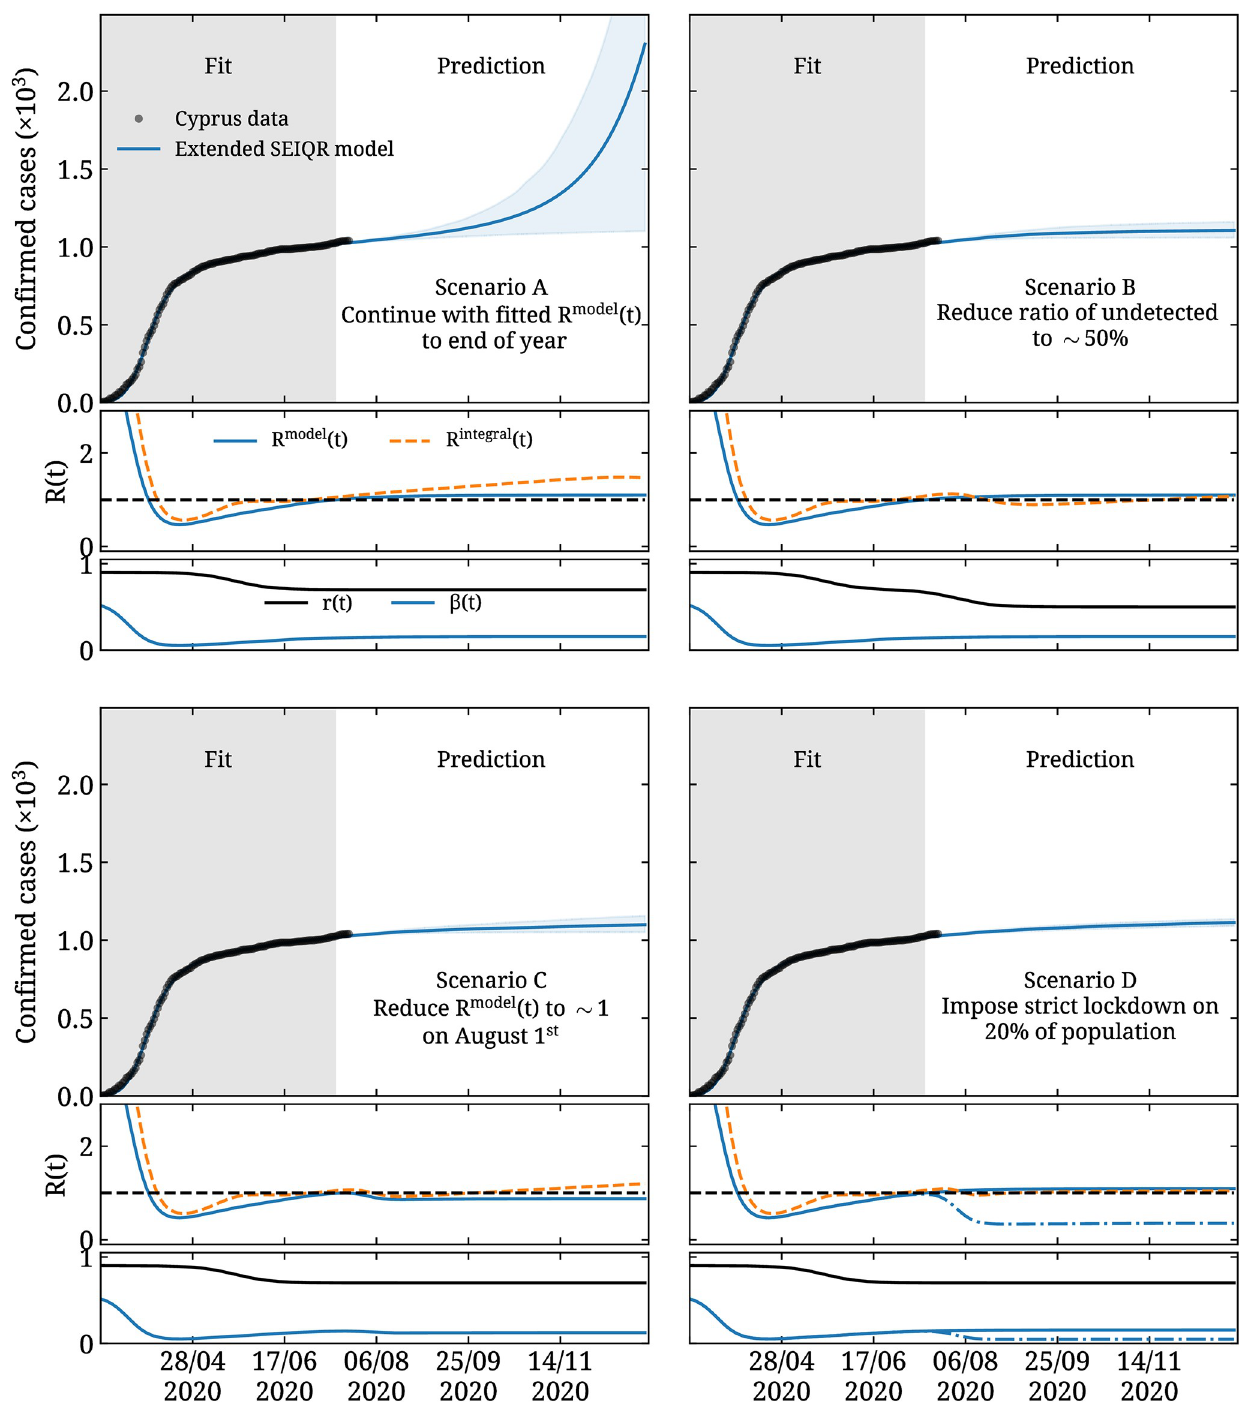
Fig 6. Forecasting using the SEIQR model. Predicting the evolution of COVID-19 for scenarios A and B (upper panel) and C and D (lower panel) obtained using our extended SEIQR model. In the upper part of each plot we show the reported cases in Cyprus (circles) as a function of time. The gray band shows the period used to fit the parameters, namely we use data on the reported cases up to t f = 128 or July 15 th . The blue curve and band shows our prediction for each scenario. In the central part of each plot, we show with the solid blue curve R model ( t ), and with the dashed yellow curve R integral ( t ). For the case of scenario D, the solid blue curve corresponds to R model ( t ) evaluated using β ( t ) used for 80% of the population, while the dash-dotted line shows R model ( t ) evaluated using β ( t ) used for 20%. In the bottom part we show r ( t ) (black curve) and β ( t ) (blue curve).